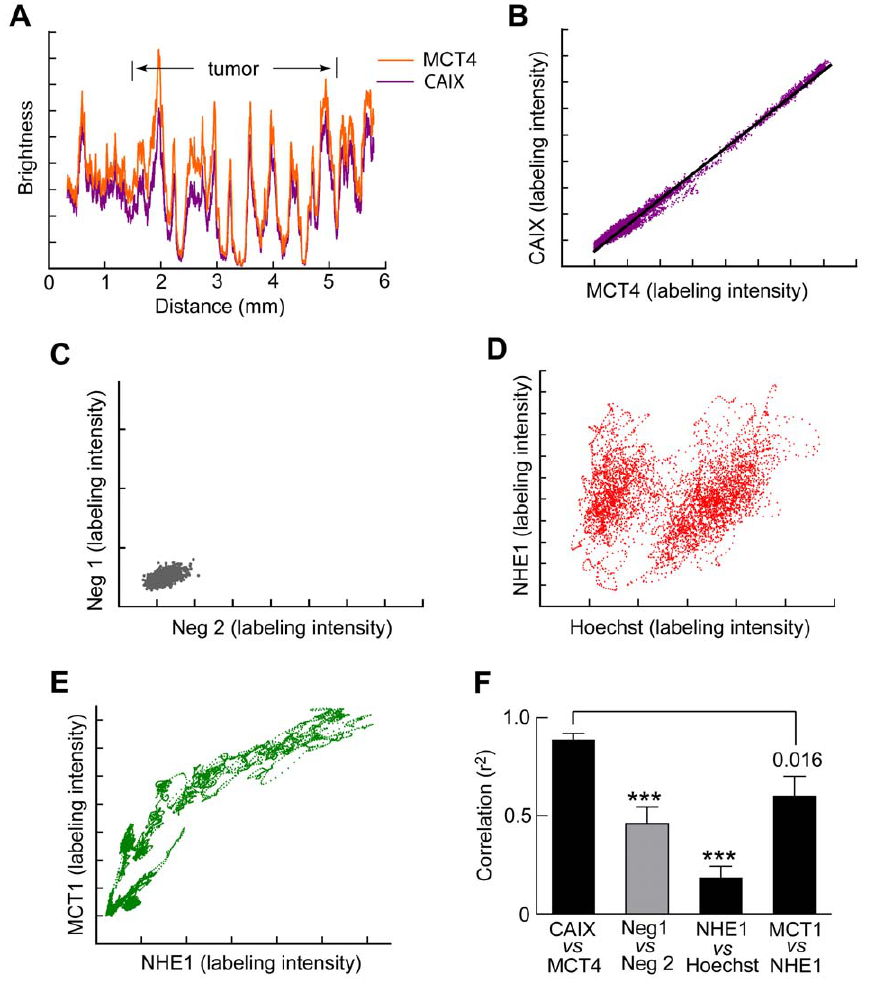
Figure 3. Profiles of CAIX and MCT4 are correlated. (A) Profiles of the intensities of labeling of CAIX and MCT4 along a sample strip 0.3875 mm wide passing through extratumoral tissue and a C6 glioma. The brightness values were scaled to give considerable overlap of the two profiles. (B) The values for CAIX and MCT4 in (A) are highly correlated. (C) The intensity profiles of the secondary antibodies in the absence of primaries show less correlation (ordinate, green fluorescent secondary; abscissa, red fluorescent secondary). (D) NHE1 labeling correlates only weakly with Hoechst labeling. (E). There is moderate correlation of MCT1 with NHE1. (A,B,D,E) are from the same glioma. (F) Average values of r 2 . First column from 8 glioma-bearing brains; other columns from 4,6 and 7 brains respectively (sections labeled for the appropriate pairs were not made for all